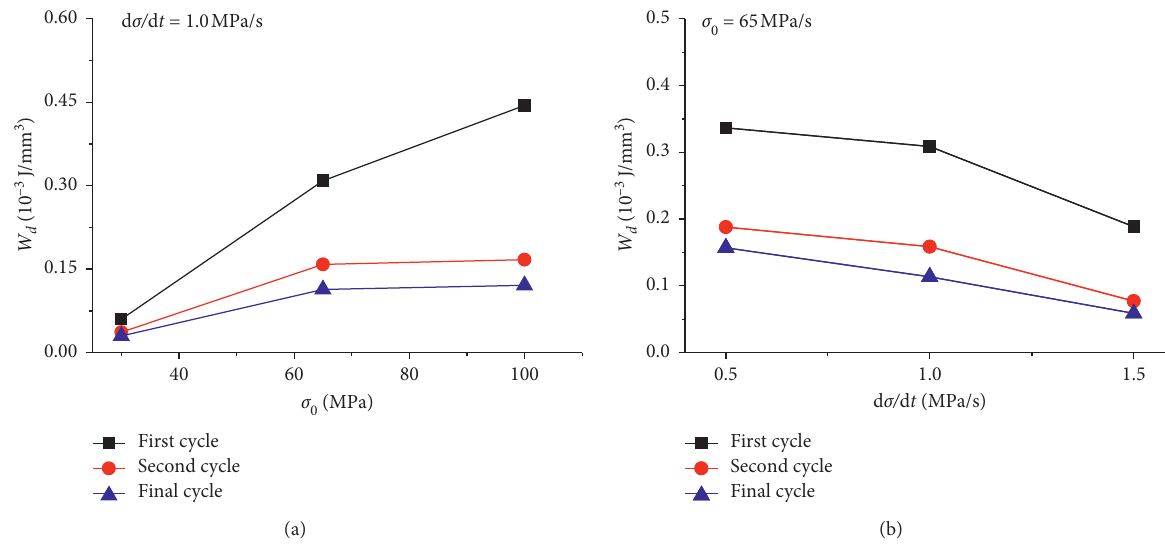
Figure 6: The dissipated energy during the 1st, 2nd, and final cycles versus with (a) σ